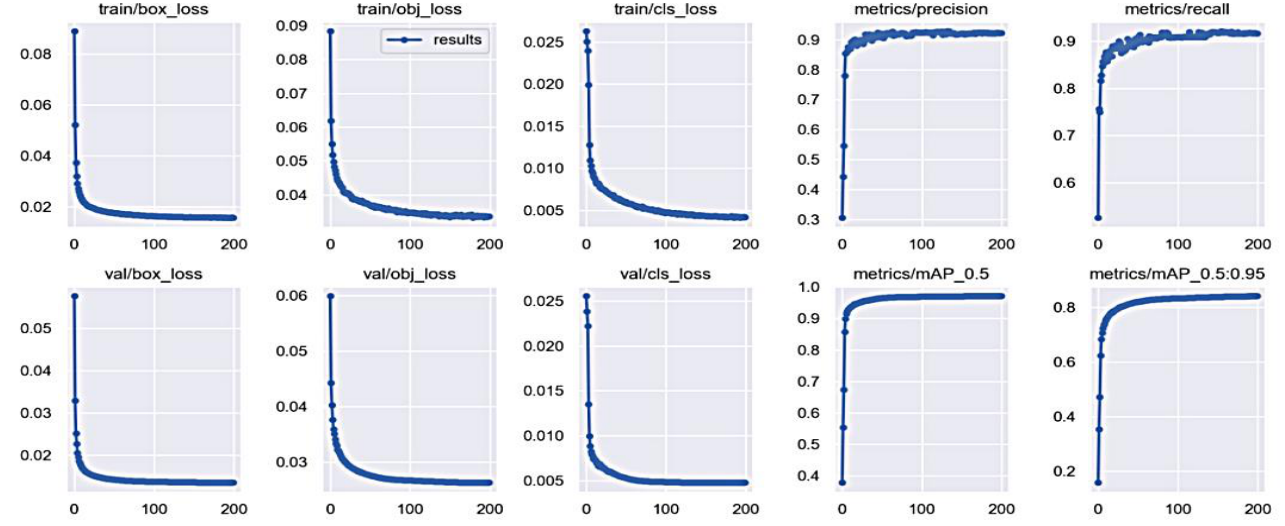
Figure 10. The complete training process of YOLOv5-GCE network. Table 8. Improved network ablation experiments. “√” represents that the improved method is ap- plied in the model. “ × ” means that the improved method is not used in the model.